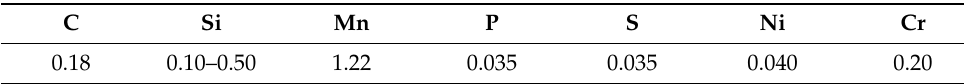
Table 1. Chemical compositions of AH36 steel.